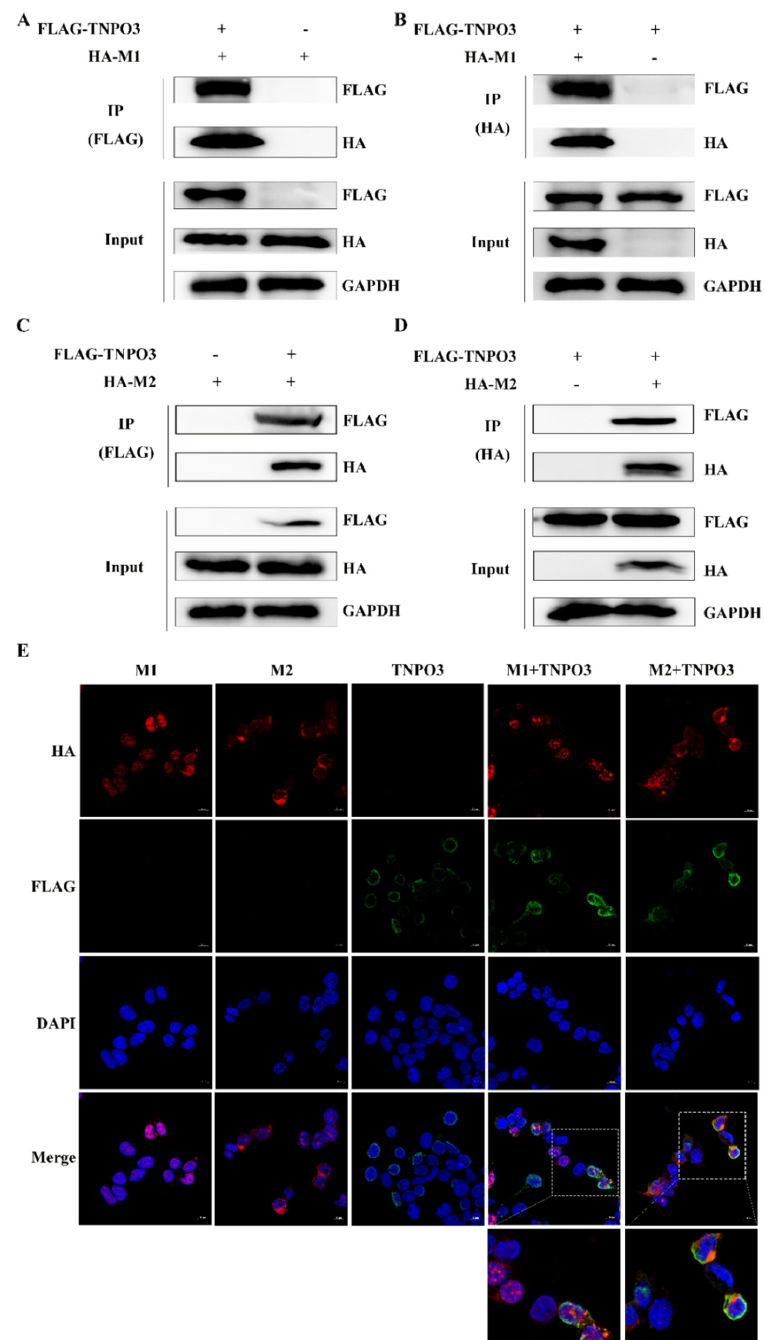
Figure 6 . TNPO3 interacts and colocalizes with M1 and M2 proteins. ( A , B ) Interaction of TNPO3 with viral protein M1 detected by co-IP assay. HEK293T cells were transfected with 3 × FLAG-CMV-TNPO3 (FLAG-TNPO3) and pCAGGS-HA-M1 (HA-M1). Co-IP assays were performed with ( A ) anti-FLAG or ( B ) anti-HA antibodies followed by Western blot analysis. ( C , D ) Interaction of TNPO3 with viral protein M2 detected by co-IP assay. HEK293T cells were transfected with 3 × FLAG-CMV-TNPO3 (FLAG-TNPO3) and pCAGGS-HA-M2 (HA-M2). Co-IP assays were performed with ( C ) anti-FLAG or ( D ) anti-HA antibody followed by Western blot analysis. ( E ) Co-localization of TNPO3 with viral proteins M1 and M2 in HEK293T cells. HEK293T cells were transfected with 3 × FLAG-CMV-TNPO3 (FLAG-TNPO3) and pCAGGS-HA-M1 (HA-M1) or pCAGGS-HA-M2 (HA-M2), and cells were fixed at 24 hpi for observation by Confocal microscopy. “Enlarge” indicates that the picture is enlarged, scale bar = 5 µ